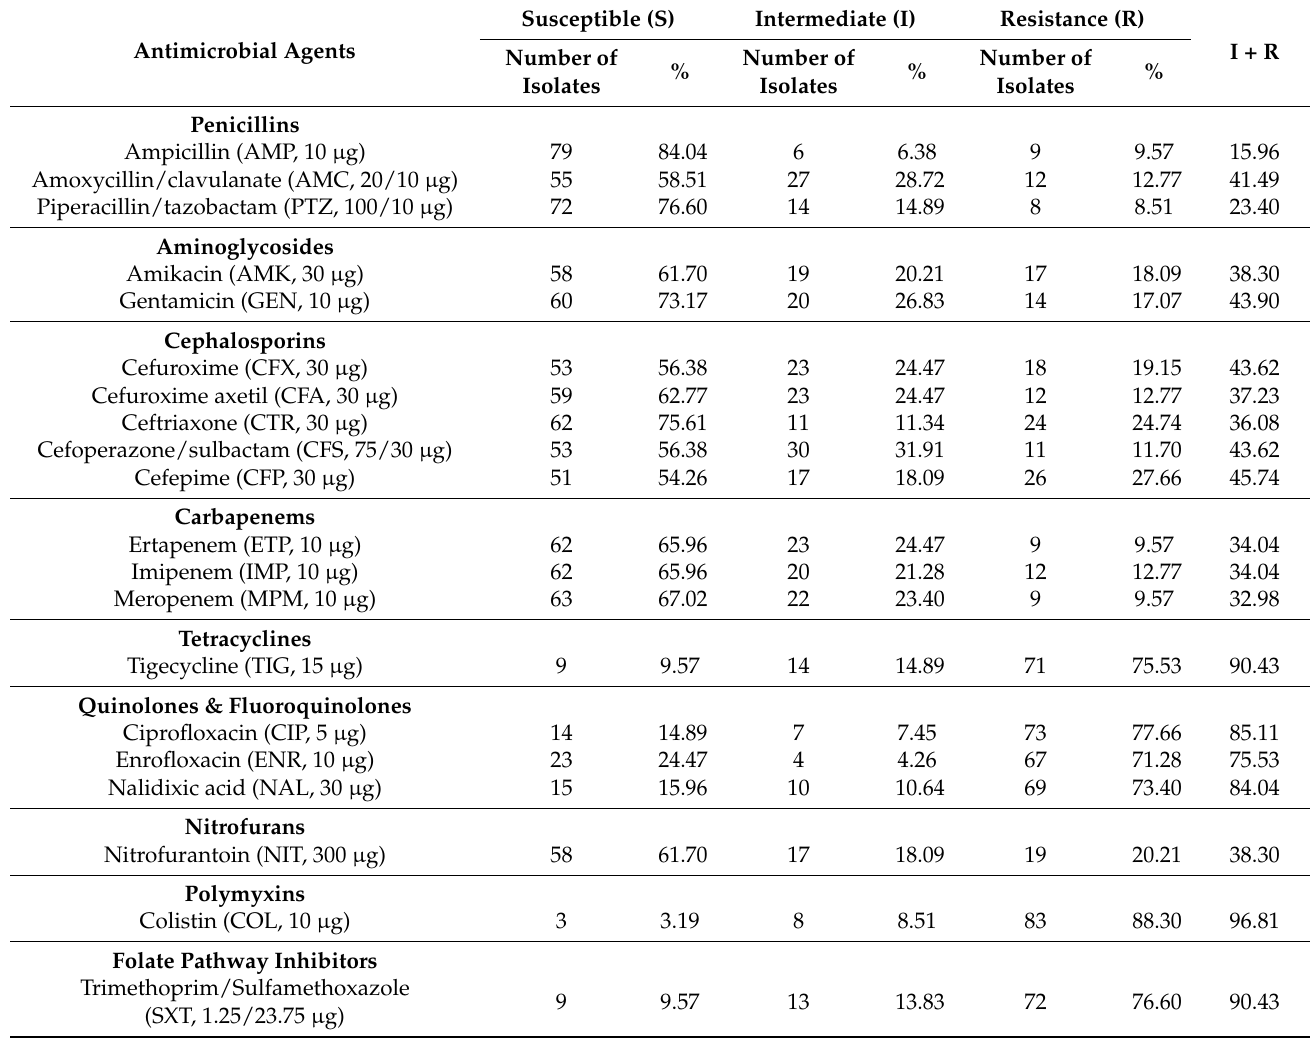
Table 3. Antimicrobial susceptibility profiles of E coli isolates ( n = 94) in the present study.